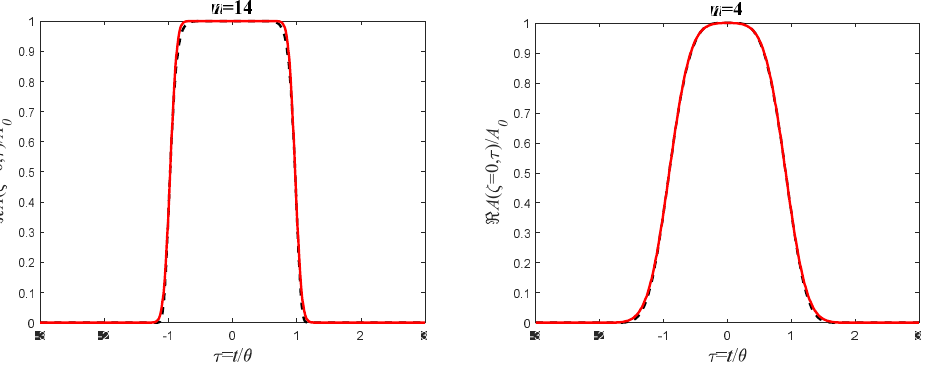
Figure 18. A comparison between smooth rectangular pulses (Equation (63), solid curves) and super-Gaussian pulses (Equation (69), dashed curves) for n = 4 (right) and n = 14 (left). In these plots, only the real part of the fields is presented. The imaginary part is zero.